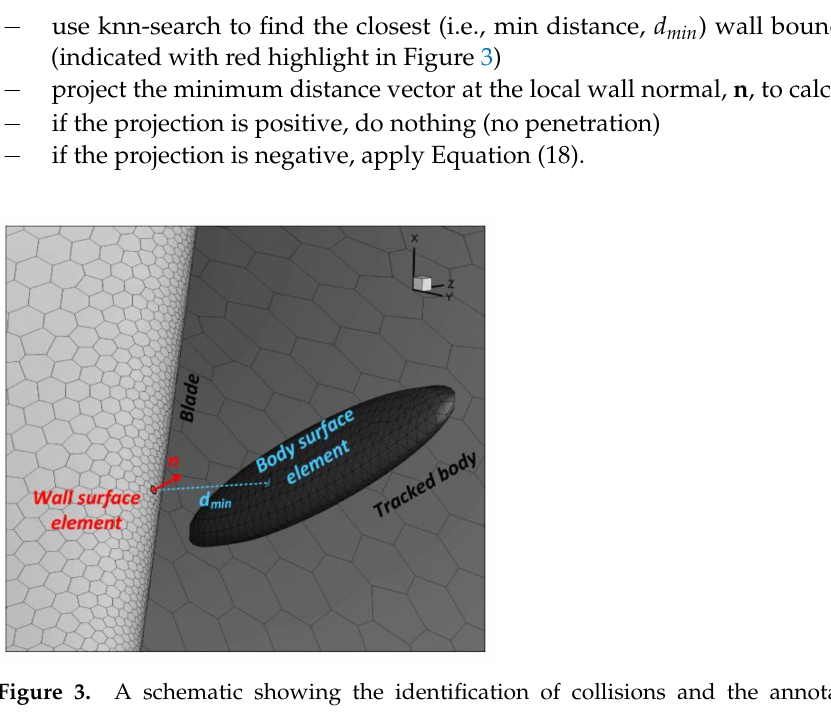
Figure 3. A schematic showing the identification of collisions and the annotations used in Equation